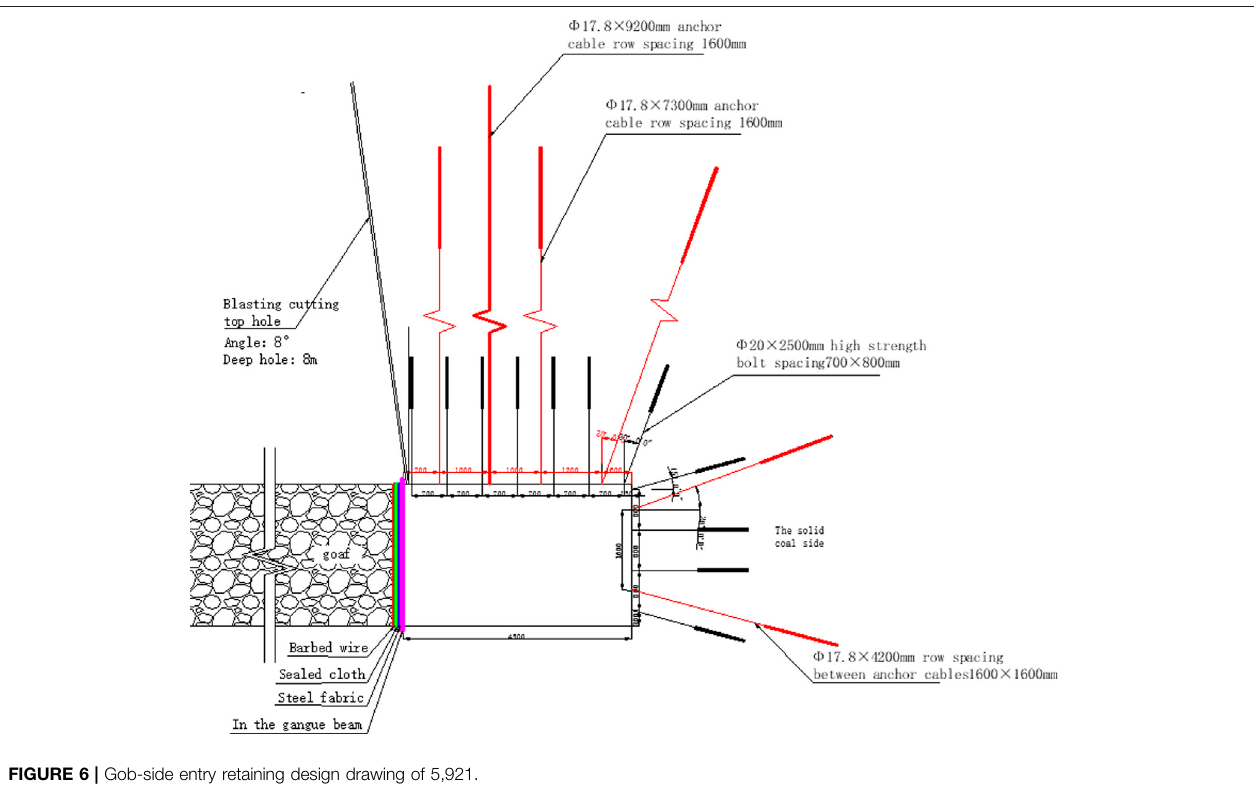
FIGURE 6 | Gob-side entry retaining design drawing of